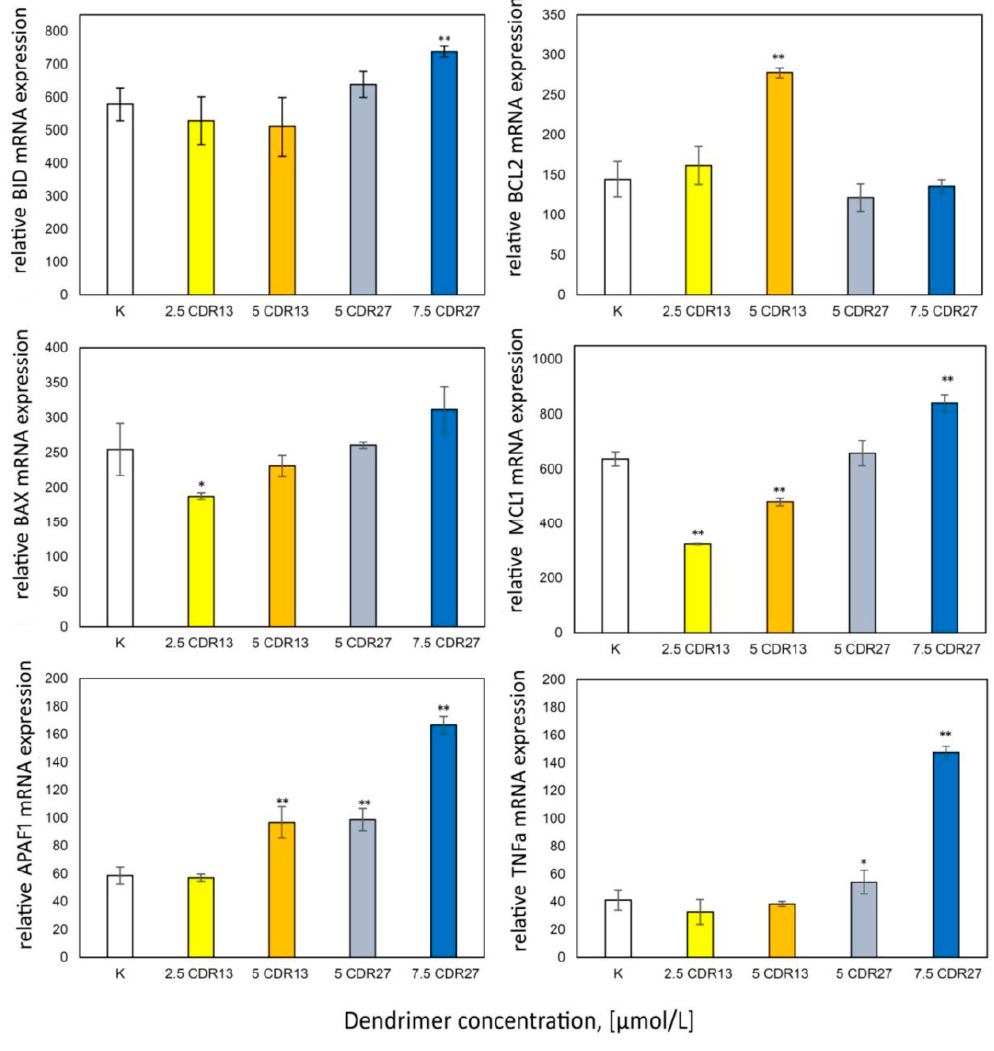
Figure 5. Relative anti-apoptotic protein expression values after 24 h incubation of 1301 cells with CRD13 and CDR27 at different concentrations. * Statistically significant differences from control cells (* p < 0.05, ** p < 0.01).